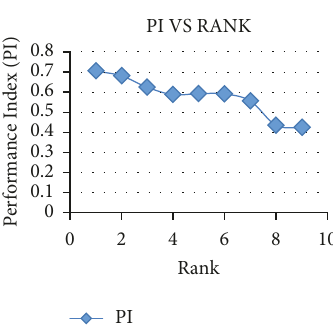
Figure 2: P i versus rank for heat-treated brass wire as